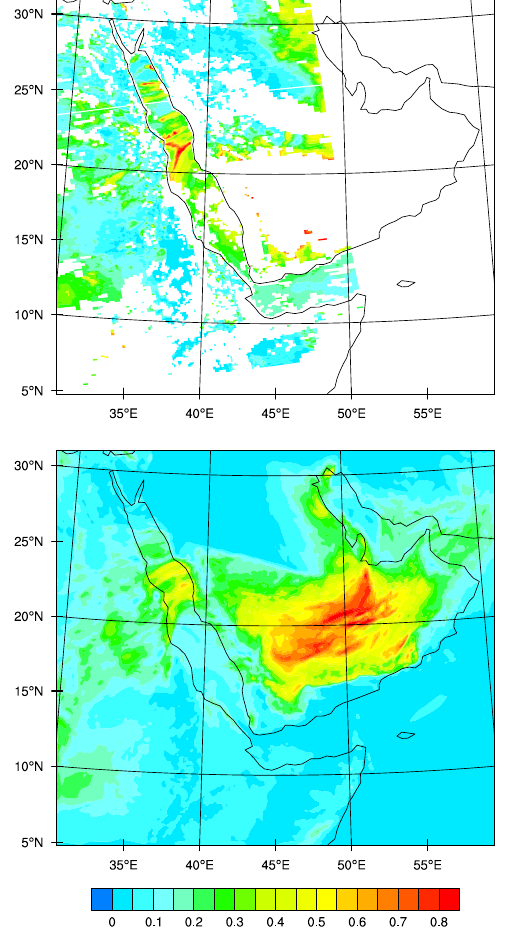
Fig. 6. Simulated AOD (600nm, bottom panel) at 11:00UTC on 14 January 2009 and observed AOD (550nm, upper panel) com- bined from two MODIS retrievals at 10:00 and 10:55UTC on 14 Jan 2009. The MODIS AOD is obtained using the standard ocean and “Deep Blue” products.